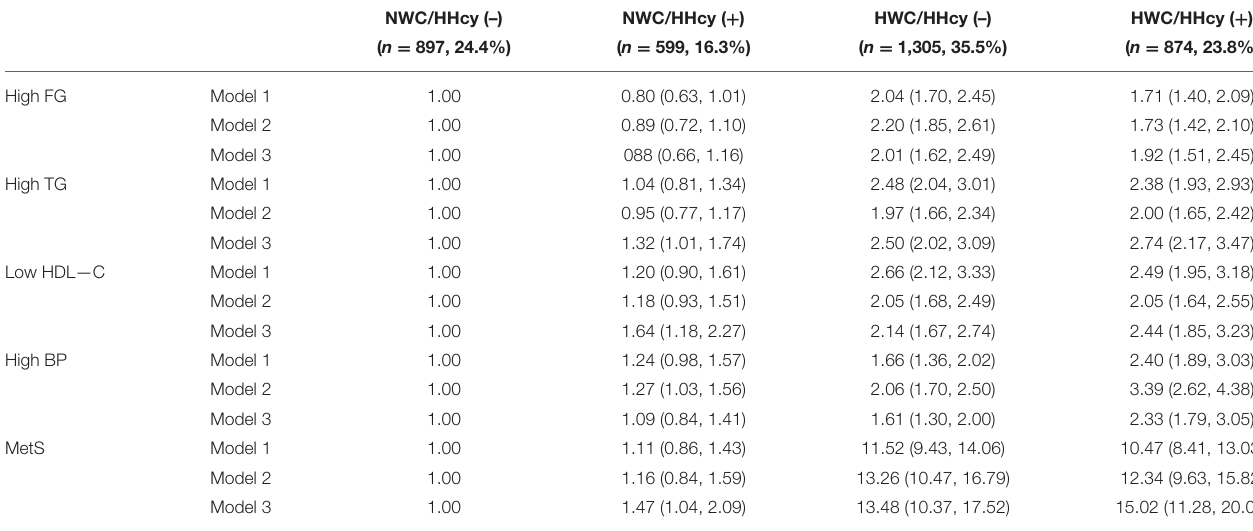
TABLE 3 | ORs of MetS and the component abnormality among the study population. NWC/HHcy (–) NWC/HHcy ( + ) HWC/HHcy